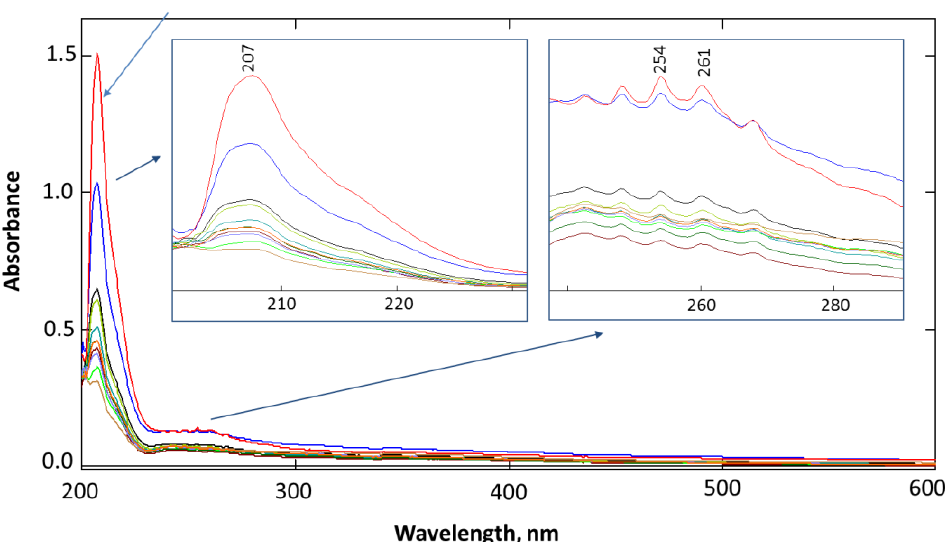
Figure 5. The UV-Vis spectrum of brine contaminated by crude oil (the most intense spectrum in red) and spectra of filtrates collected at different periods of time during filtration at a flow rate of 25 mL/min.